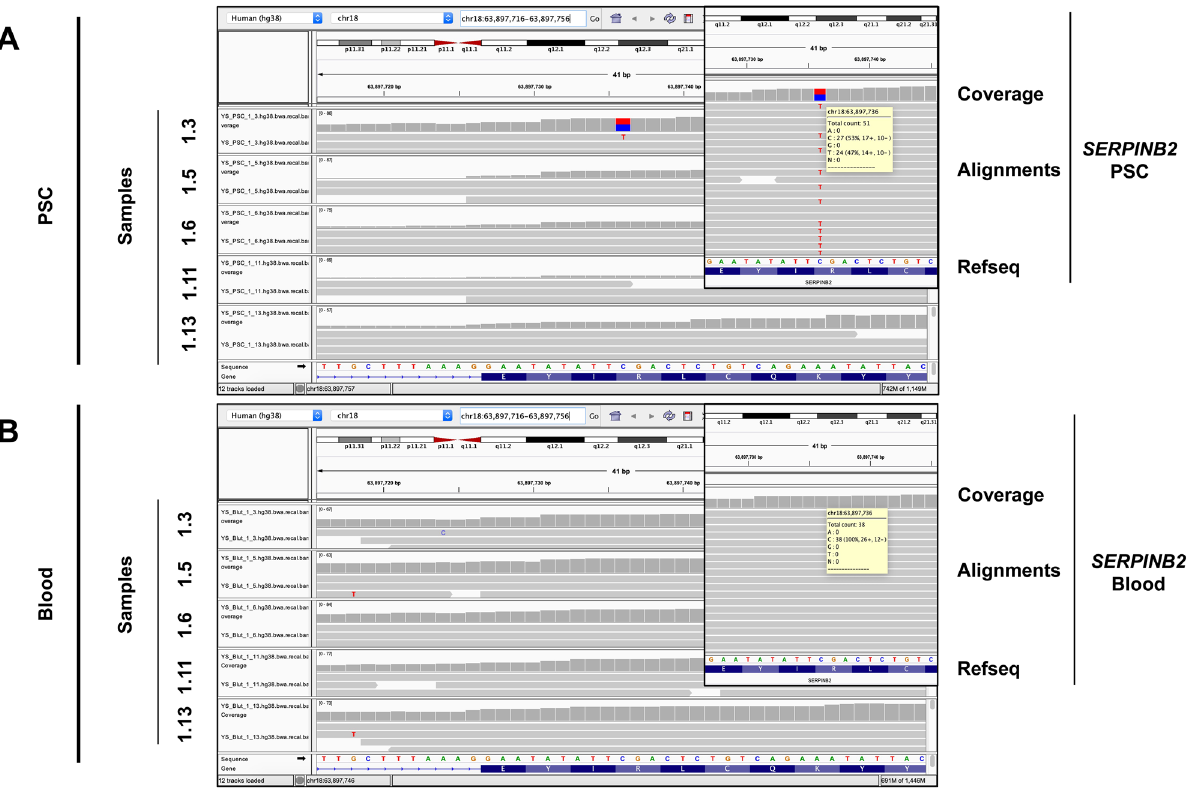
Figure 2. PSCs show unique point mutations in their genomes compared to matching blood counterparts at selected gene locations. Visualization of selected point mutation of the SERPINB2 gene in PSC samples with the IGV tool. Direct comparison to base sequences at the same gene localization of matched blood samples show no variant verifying the change in the PSCs genome as a somatic mutation.